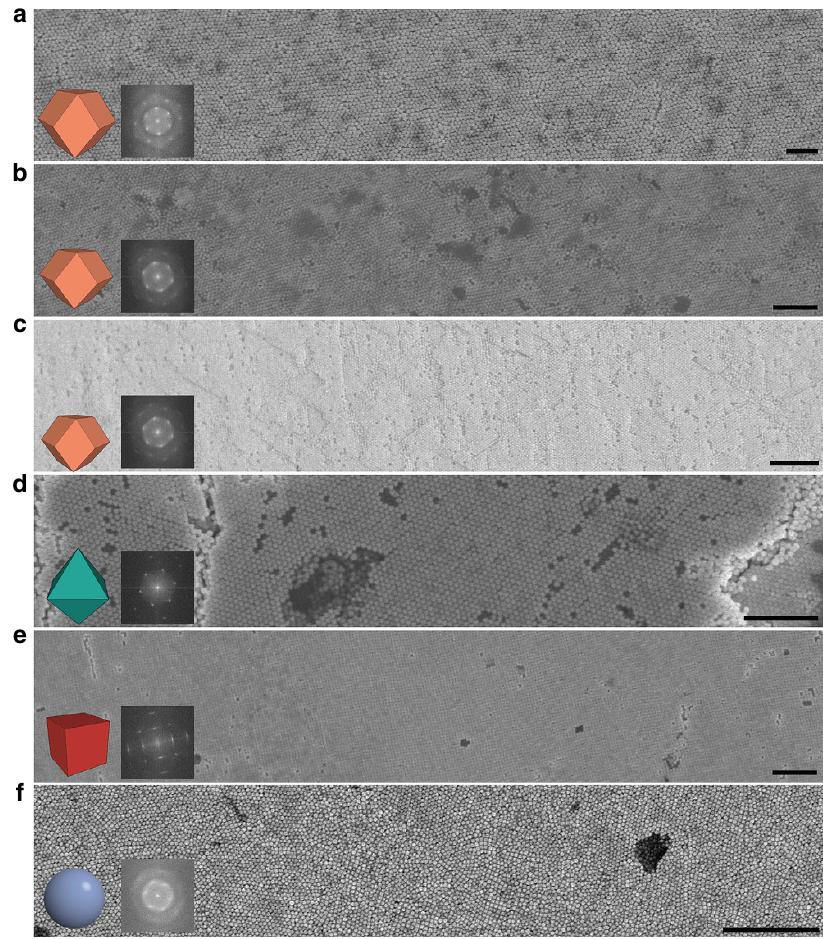
Figure 1 | Large-scale SEM images of superlattices using gold nanocrystals. The nanocrystal shapes are ( a ) large (lRD), ( b ) medium (mRD), ( c ) small (sRD) rhombic dodecahedra, ( d ) octahedra, ( e ) cubes and ( f ) spheres. The view is chosen perpendicular to the bottom of the superlattice surface, which was in contact with the glass cuvette before being peeled off. The particle shape and an image calculated from a fast Fourier transform of the SEM image are shown as insets. As confirmed by sharp spots in the diffraction images, all superlattice films with exception of that formed from spheres are single domains across the SEM image. Scale bar, 1 m